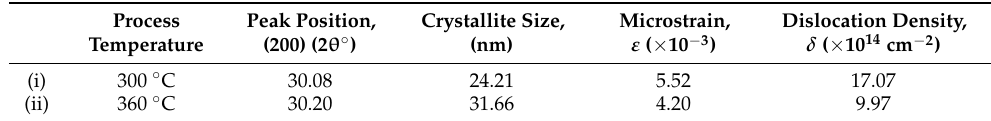
Table 1. Estimated structural properties of the PbS nanoparticles with respect to the calcination temperature.